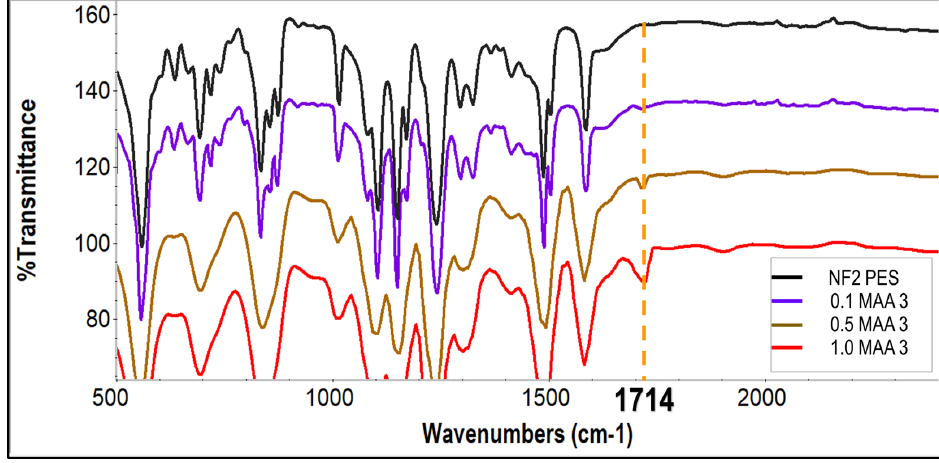
Figure 4. FTIR ‐ ATR spectra of the unmodified NF2 PES and UV ‐ grafted membranes 0.1 MAA3, 0.5 Figure 4. FTIR-ATR spectra of the unmodified NF2 PES and UV-grafted membranes 0.1 MAA3, MAA3 and 1.0 MAA3. 0.5 MAA3 and 1.0